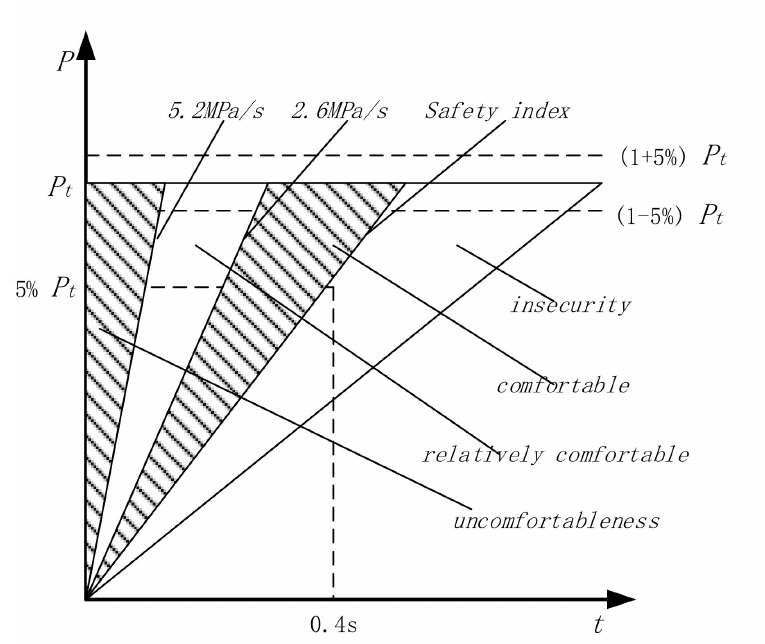
Figure 4. Pressure change rate range of an automatic pressure regulating